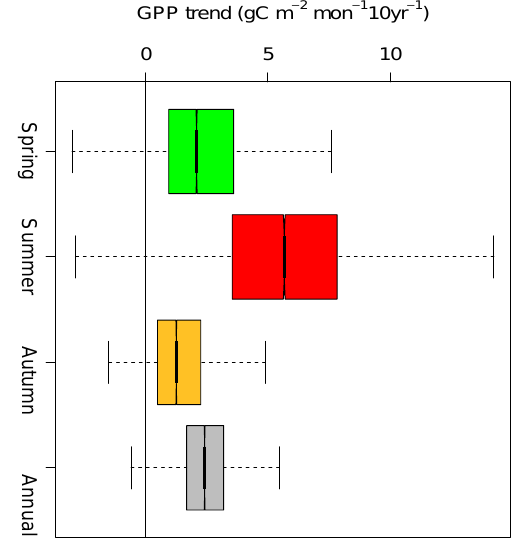
Figure 5. Box plot showing grid distributions of seasonal GPP trends for GPPsat. The GPP trends are expressed in gCm − 2 month − 1 10yr − 1 . The black band and middle notch rep- resent the 2nd quartile or median; box extents mark the 25th (1st quartile) and 75th (3rd quartile) percentiles. Whiskers extend from the smallest non-outlier value to the largest non-outlier value. The colours, green, red, orange, and grey represent spring, summer, autumn, and annual seasonal trends respectively. As described in Sect. 2.1.2, GPP trends for winter have not been assessed in this